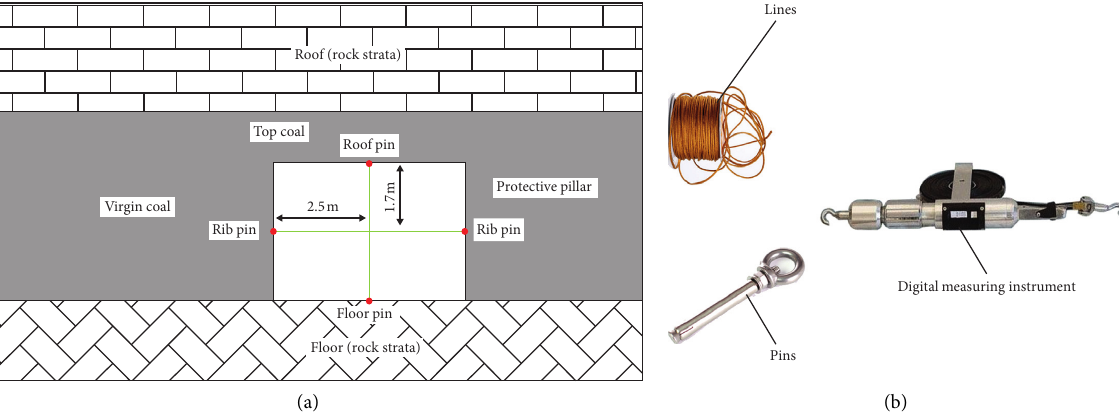
Figure 4: Roadway convergence measurement in field. (a) Layout of the measurement station. (b) Measurement devices.